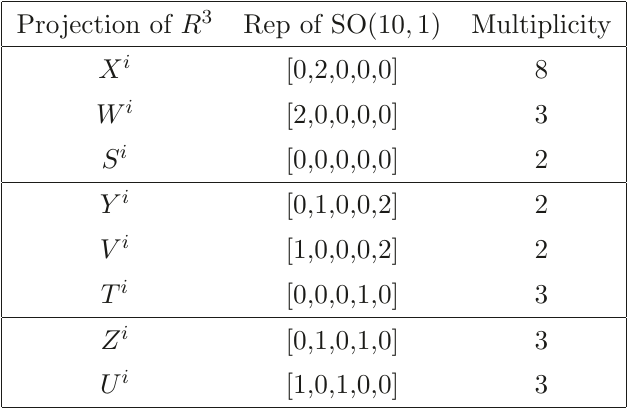
3 R in eleven dimensions. In each case, the index i runs over the ⊗